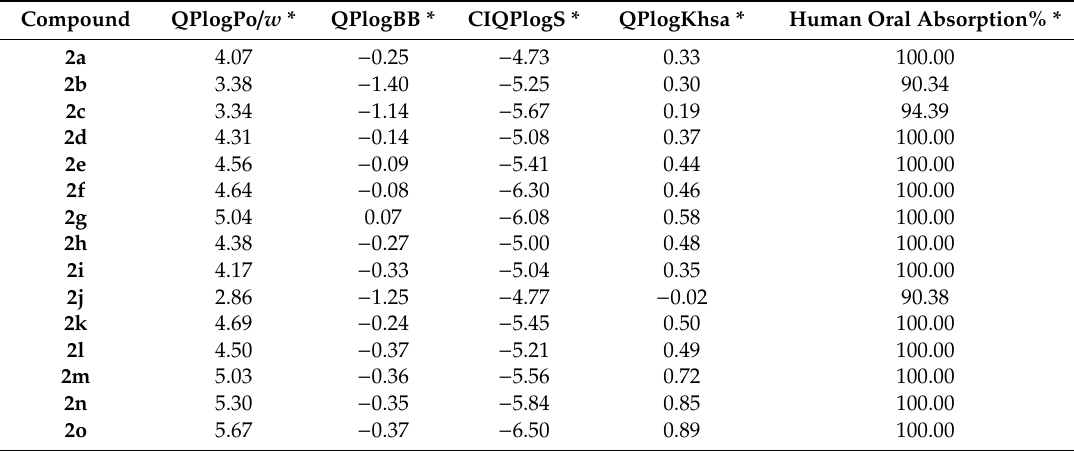
Table 3. Predicted Absorption, Distribution, Metabolism, and Excretion (ADME) properties of compounds 2a – o